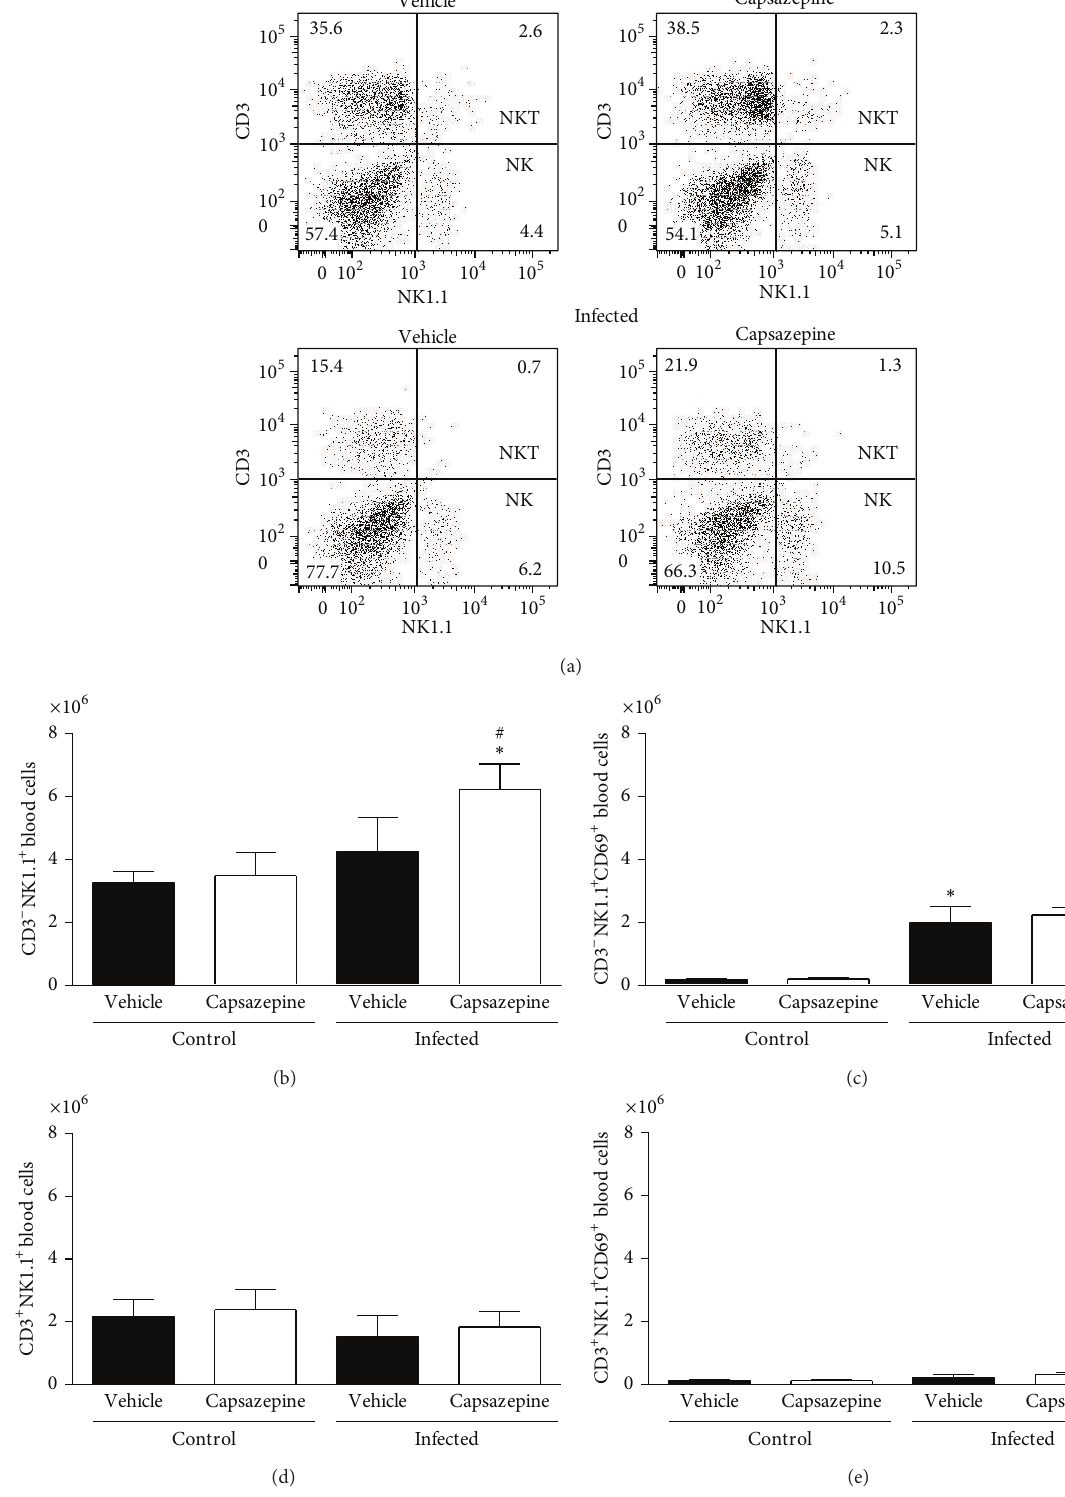
Figure 4: Effect of capsazepine on peripheral blood CD3 − NK1.1 + and CD3 + NK1.1 + cells. (a) Representative two-colour dot-plots for peripheral blood CD3 − NK1.1 + (NK) and CD3 + NK1.1 + (NKT) cell populations from uninfected and Plasmodium berghei ANKA-infected mice (10 5 infectedRBCs/animal;i.p.).Circulating(b)CD3 − NK1.1 + and(c)CD3 − NK1.1 + cellnumbersinuninfectedand Plasmodiumberghei ANKA- infected mice (10 5 infected RBCs/animal; i.p.). Expression of CD69 on circulating (d) CD3 − NK1.1 + and (e) CD3 − NK1.1 + cells. Capsazepine (50 𝜇 g/animal, 2x day, for 6 days) was administered from 24h after infection. Vehicle- (10% DMSO in saline) treated animals were used as controls. Data are expressed as mean ± SD, 𝑛 = 5 per group. ∗ 𝑃 < 0.05 compared with respective uninfected (control)